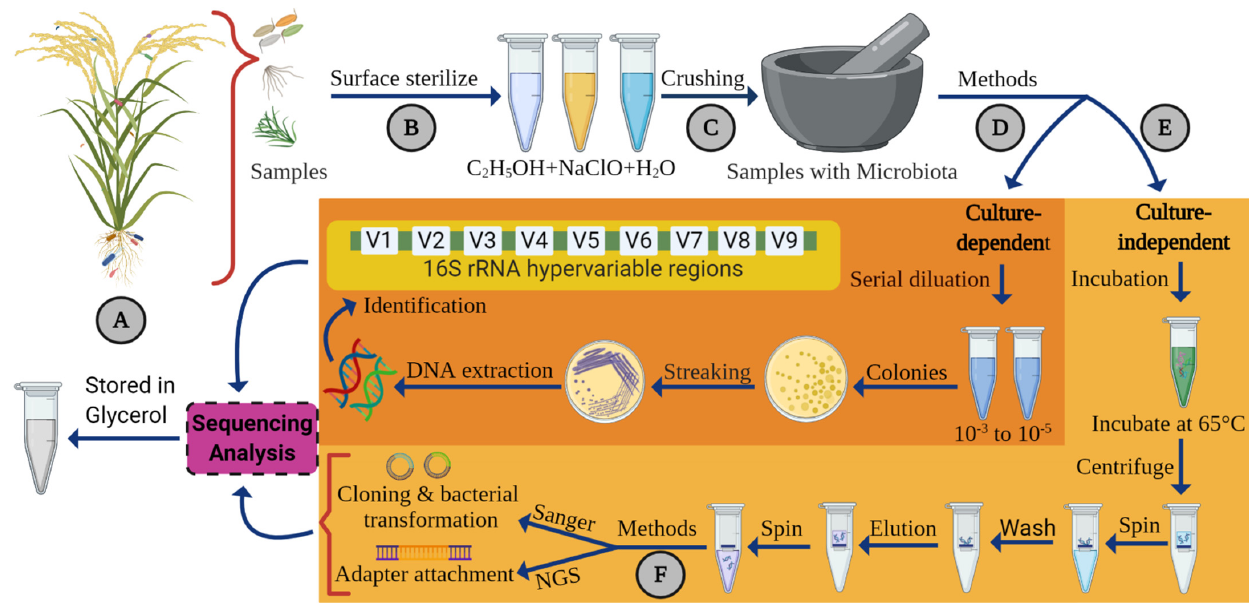
Figure 3. Methods of isolation and identification of rice endophytic bacterial communities: ( A ) samples collected from different parts of rice plants; ( B ) standard surface sterilization of the samples; ( C ) crushing of samples, followed by two methods for isolation, namely ( D ) culture ‐ dependent method and ( E ) culture ‐ independent method. ( F ) In culture ‐ independent method, identification via Sanger sequencing or NGS; the figure was created with BioRender (https://biorender.com/, accessed on 25 August 2021).